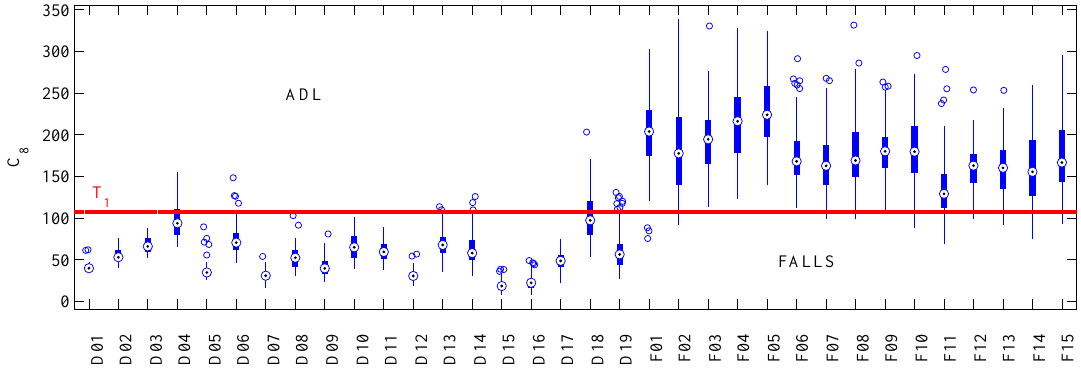
Figure 4. Maximum value per activity obtained with C 8 . Most T 1 threshold crossings (horizontal red line) are contained in activities D04, D18 and